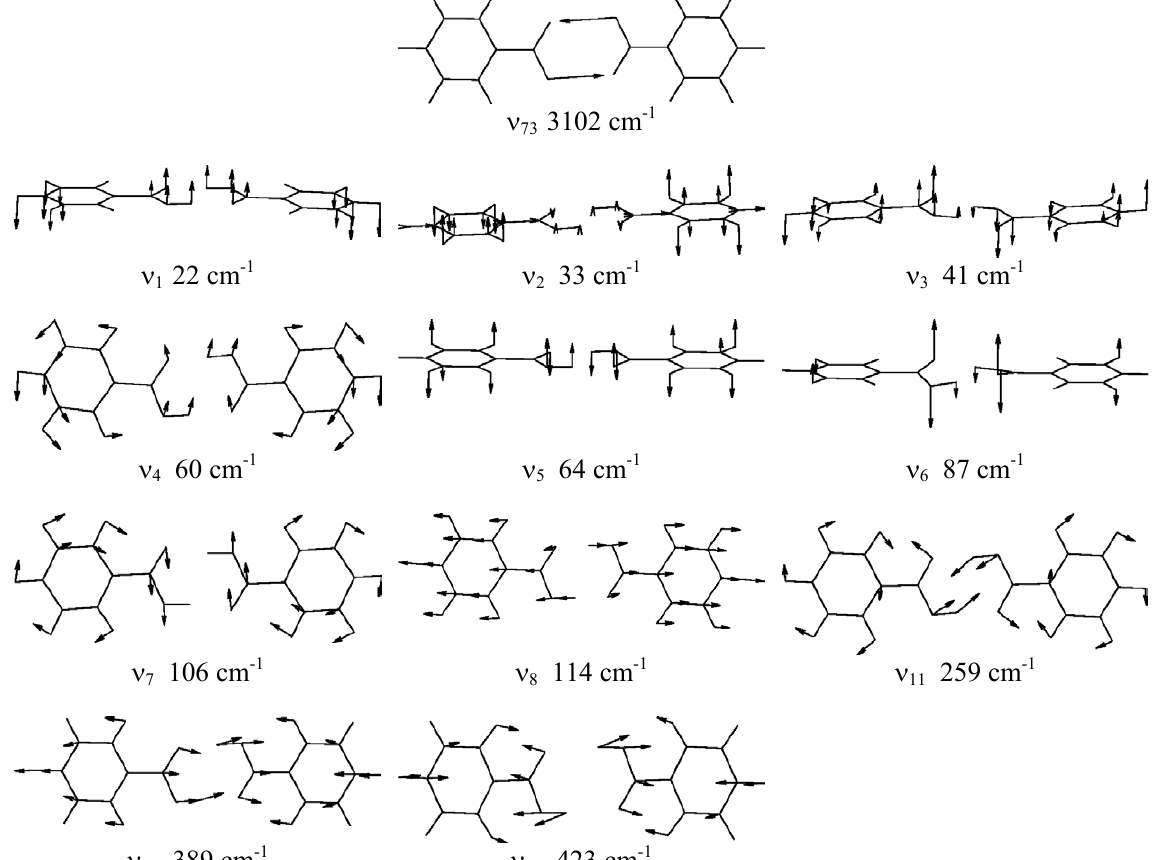
Figure 2. Normal modes of benzoic acid calculated by the B3LYP/6-311++G** method.